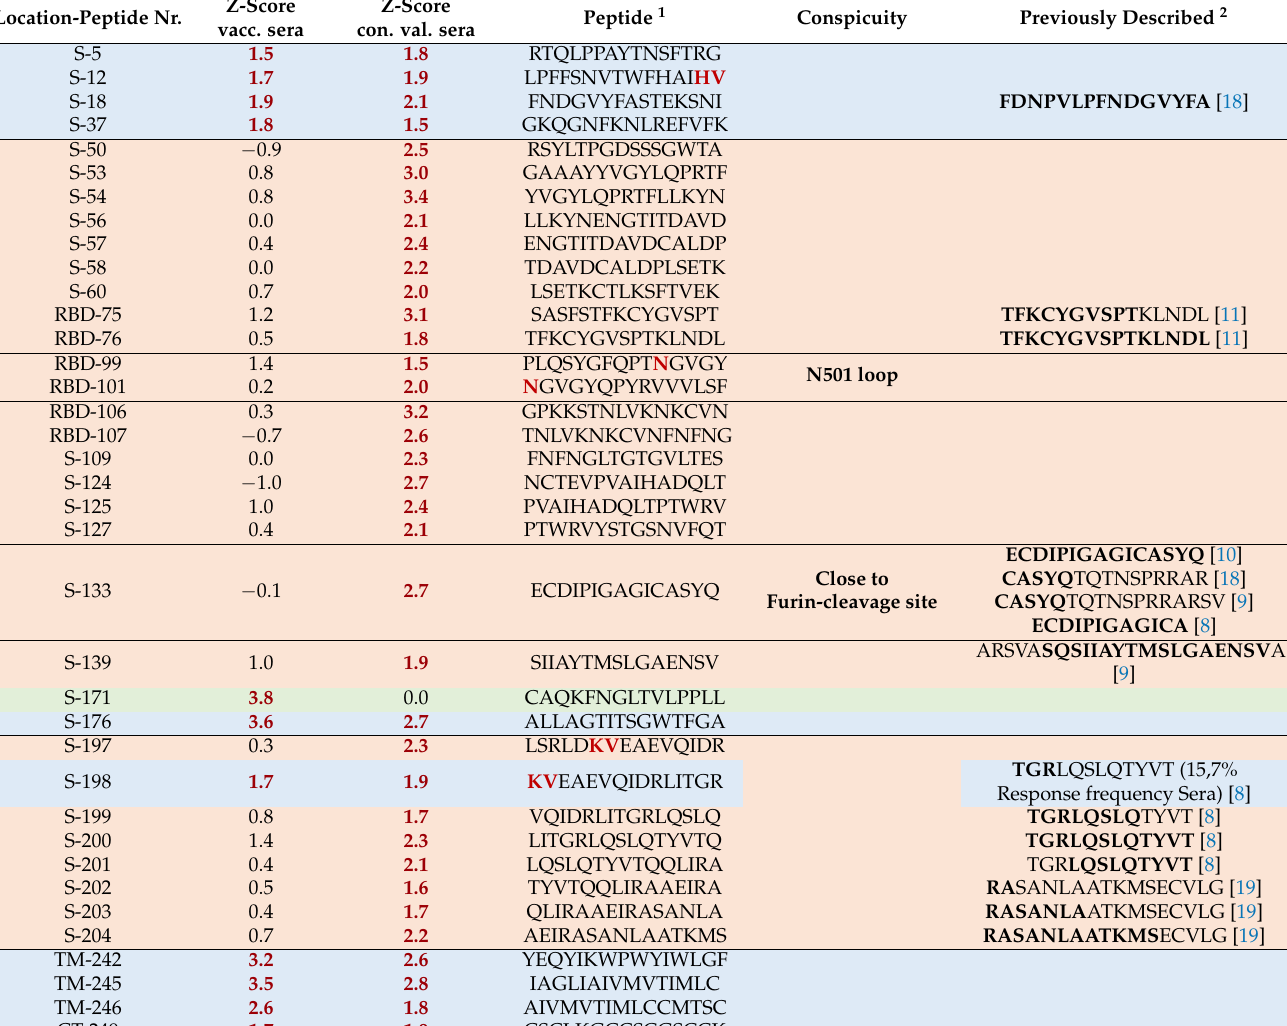
Table 1. Identified linear S protein epitopes in vaccinated-elicited sera and convalescent sera. Red: Z-score ≥ 1.5. High- lighted: Blue: epitopes significant in both sera groups; red: epitopes only significant in convalescent sera; green: epitopes only significant in vaccinated-elicited